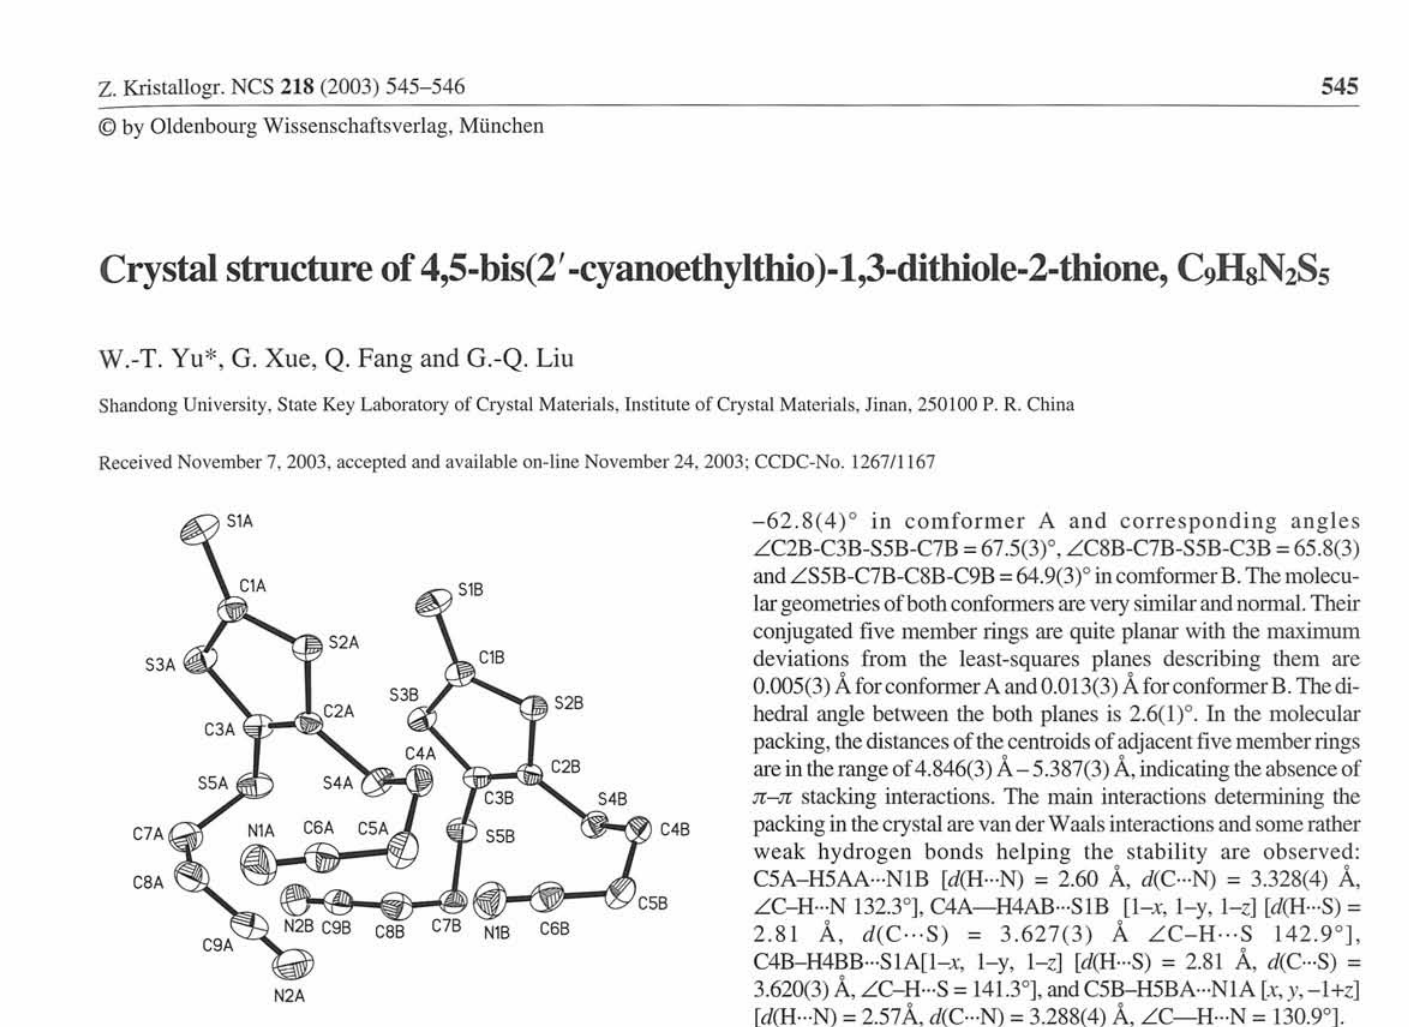
Table 1. Data collection and handling.